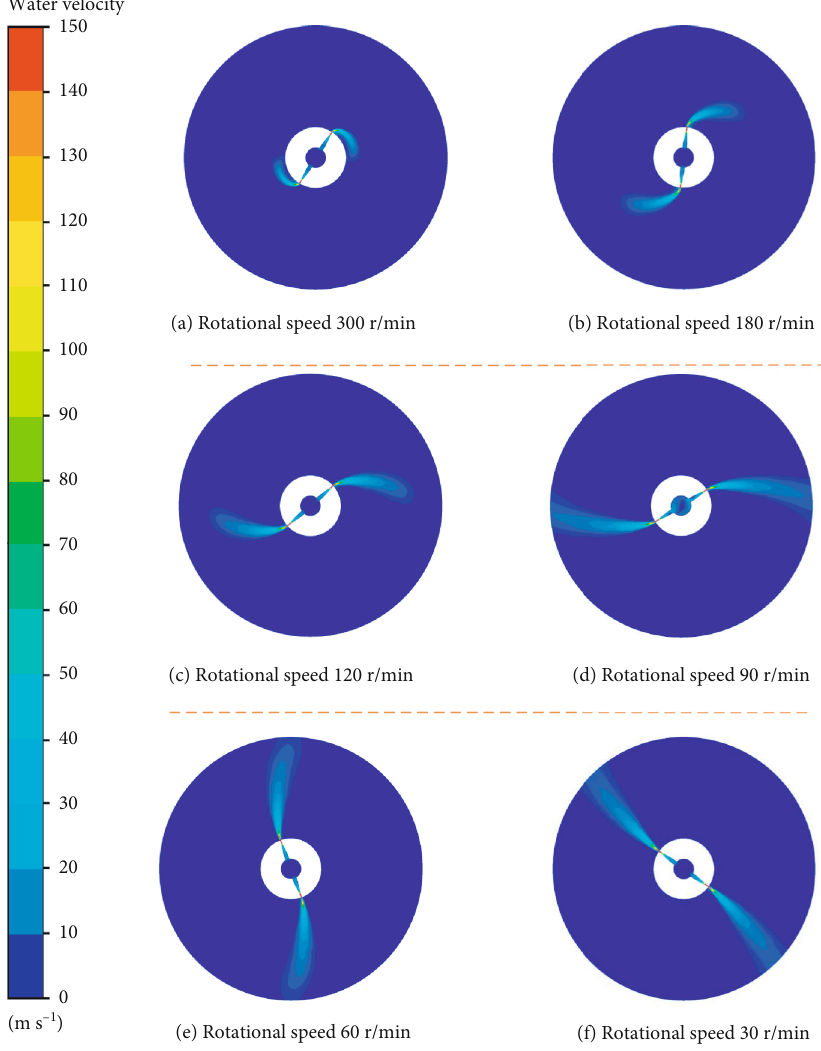
Figure 17: Contour maps of jet velocity for the two-nozzle combination at di ff erent rotation